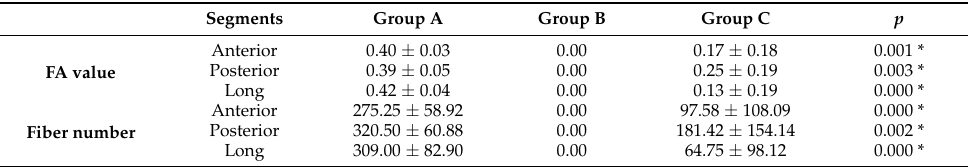
Table 6. The diffusion indices in the left AF segments #